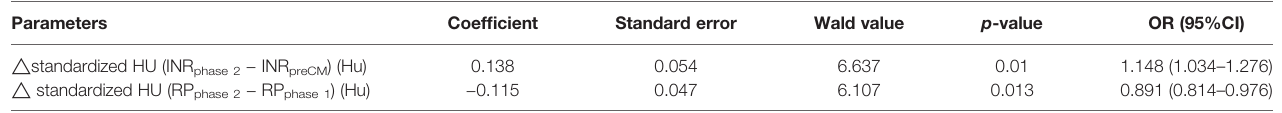
TABLE 4 | Multivariable logistic regression analysis to identify independent factors that could predict breast lesion with RE malignancy. Parameters